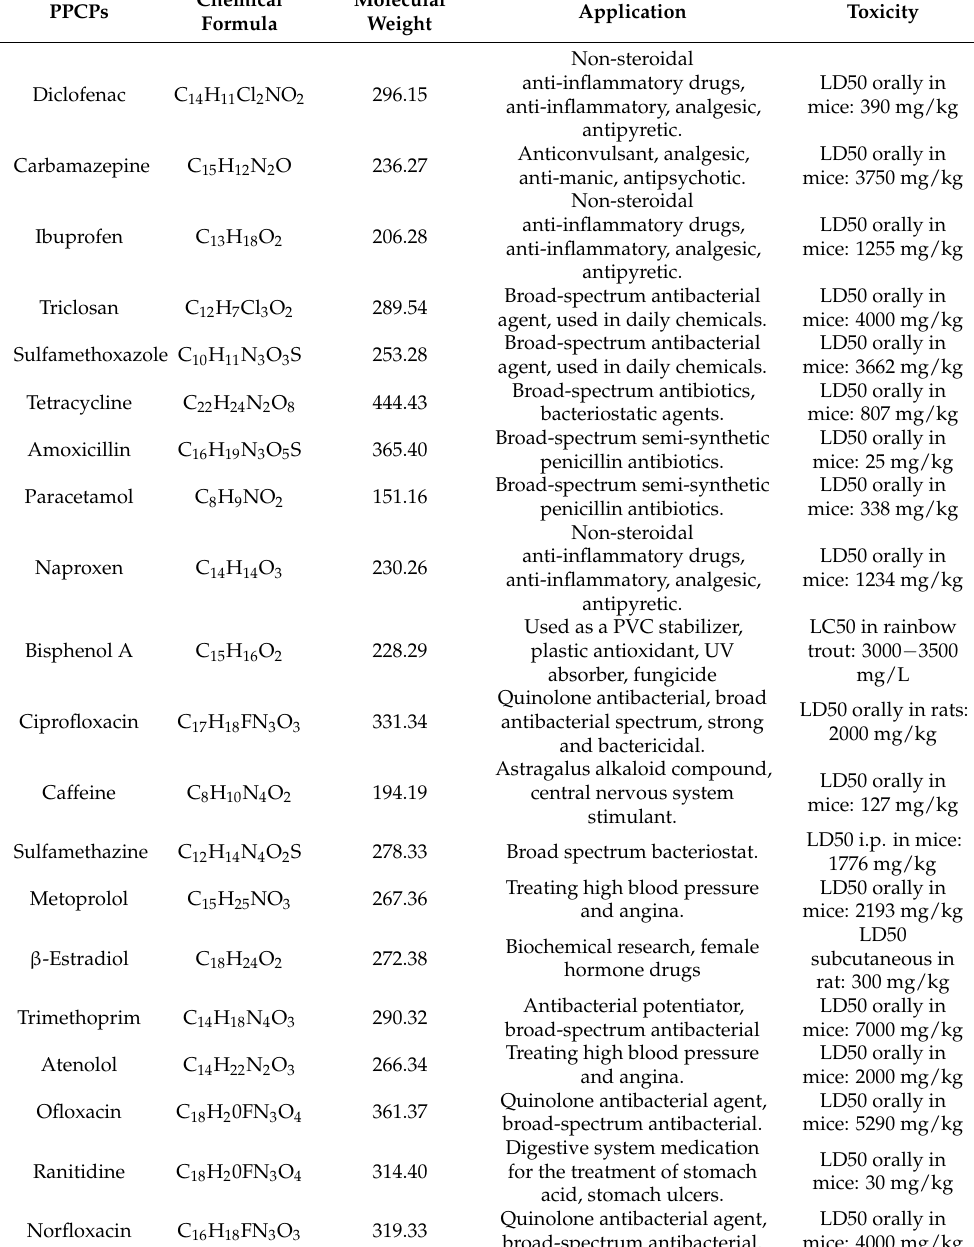
Table 1. Characteristics of top 20 common PPCPs